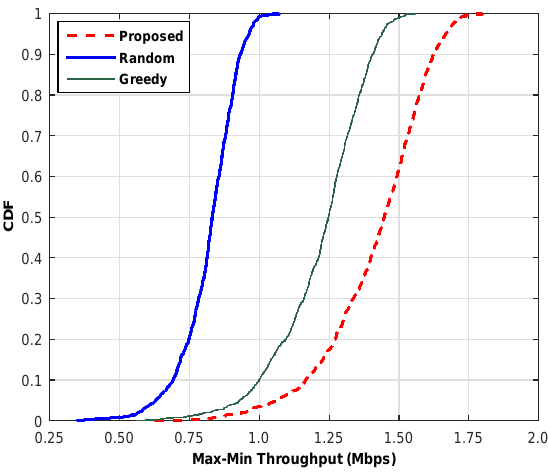
Figure 7. Cumulative distribution function of throughput.